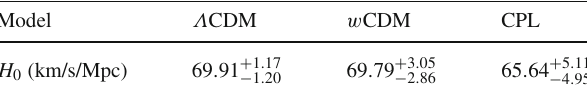
Table 3 Average values of H 0 for different models based on ∼ 300 mock realisations of the data in Fig. 1. This is to be compared with the GPresults,inparticularthe ν = ∞ case,quotedinTable2.Asexpected, Λ CDM has smaller error, while w CDM has comparable error, but CPL leads to a larger error